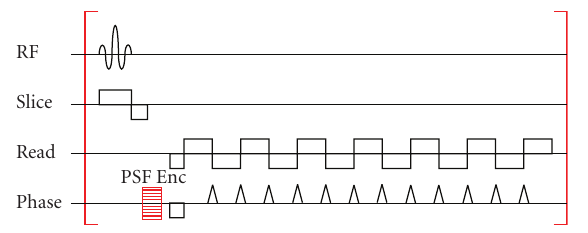
Figure 1: EPI pulse sequence with additional PSF encoding gradient (PSF Enc) on the phase encoding axis. In order to acquire the complete PSF data, EPI acquisitions are repeated for the complete PSF Encoding gradient table.